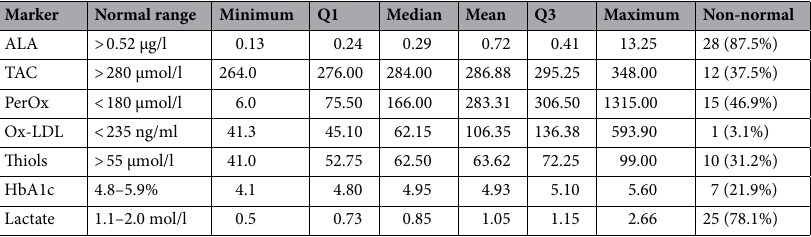
Table 3. Summary statistics of mitochondrial function markers. Q1–Q3: interquartile range; non-normal: number (%) of patients with values outside normal range. ALA = Alpha-lipoic acid; ox-LDL = oxidised LDL; PerOx = total lipid peroxide; TAC = total antioxidant